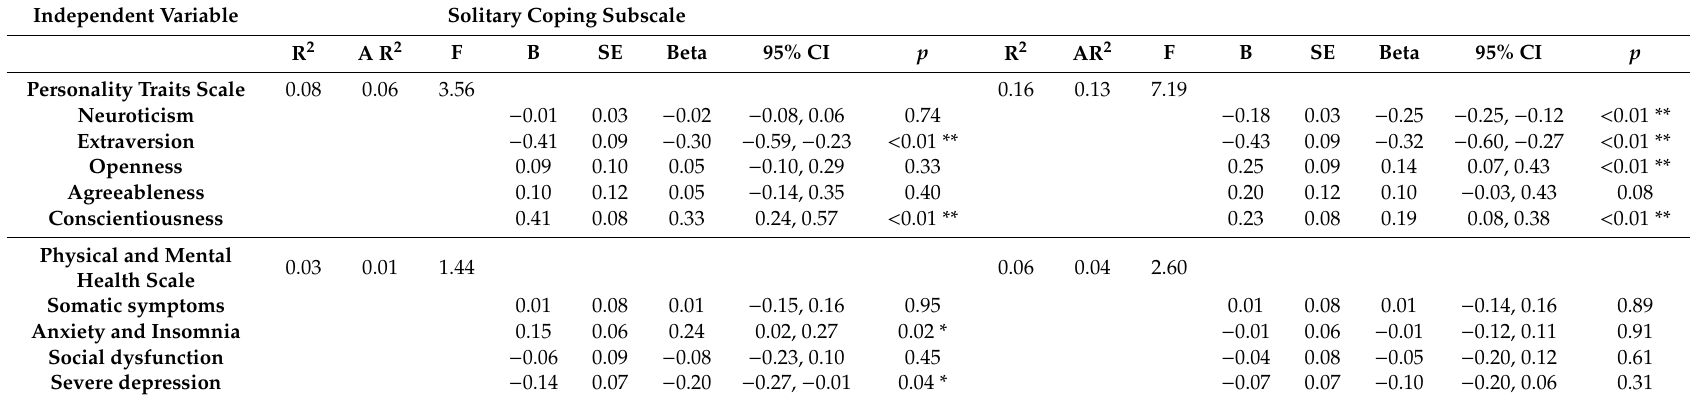
Table 4. Multiple regression analysis identifying a significant correlation between the Solitude Capacity Scale † and two dimensions of the Personality Traits Scale and the Physical and Mental Health